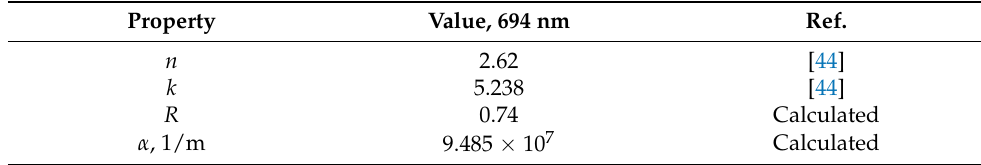
Table A8. Liquid -Ge—optical properties.